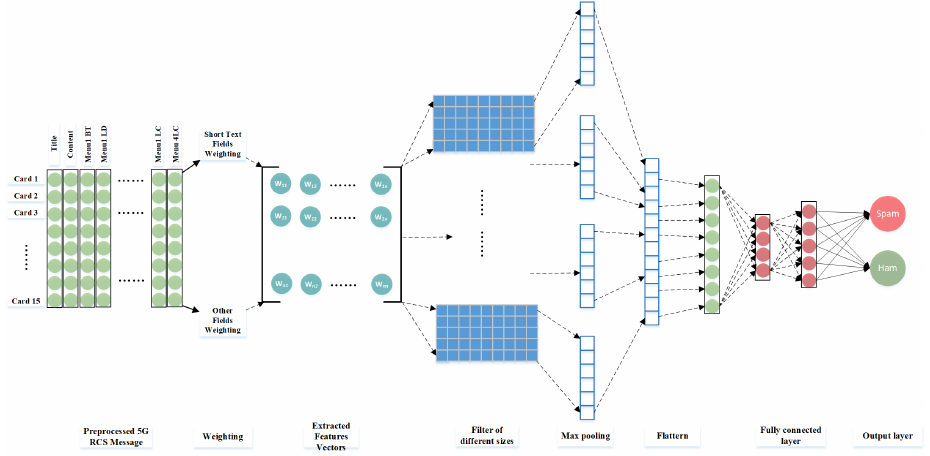
Figure 3. Proposed CNN for RCS